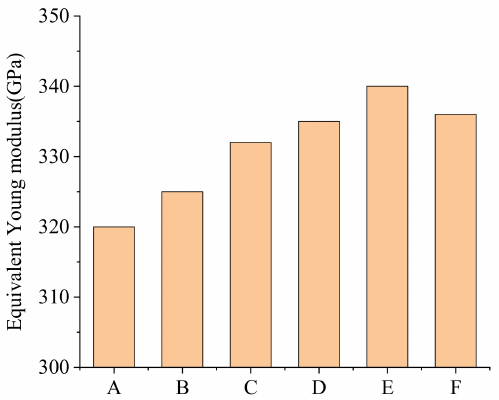
Figure 17. Equivalent Young’s modulus of calcined bauxite